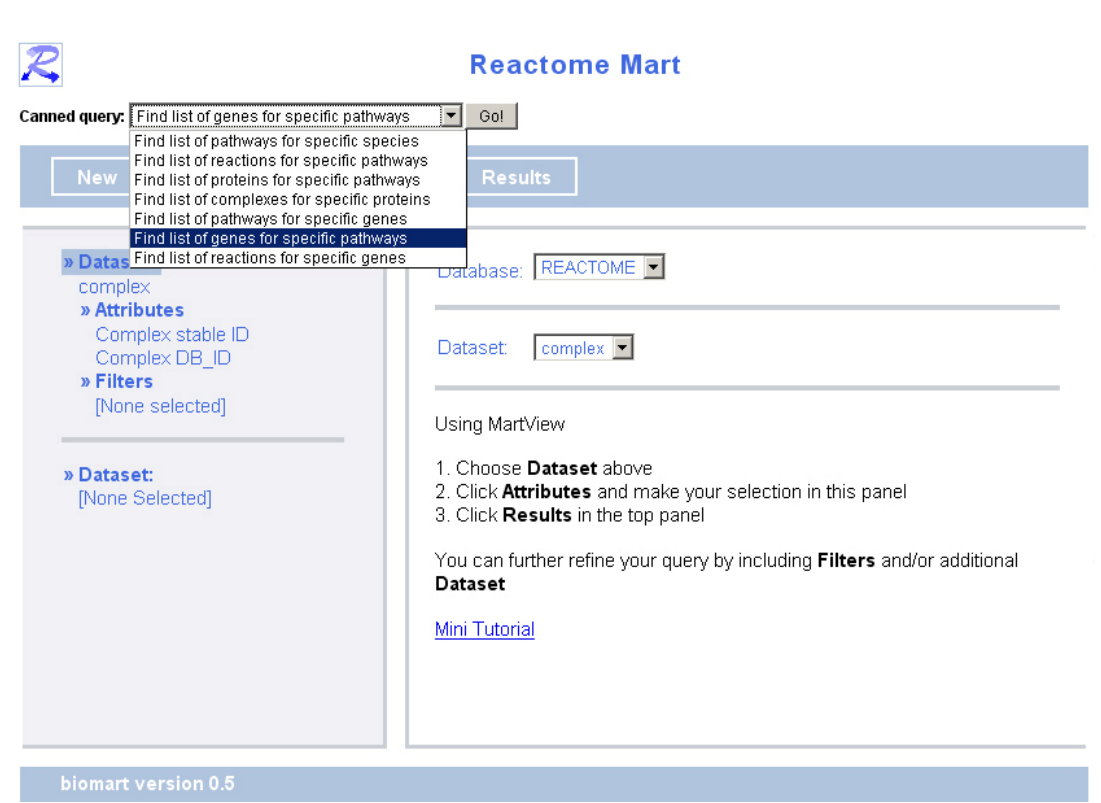
Figure 6: The Reactome Mart interface showing details of ‘canned’ queries available through a pull-down